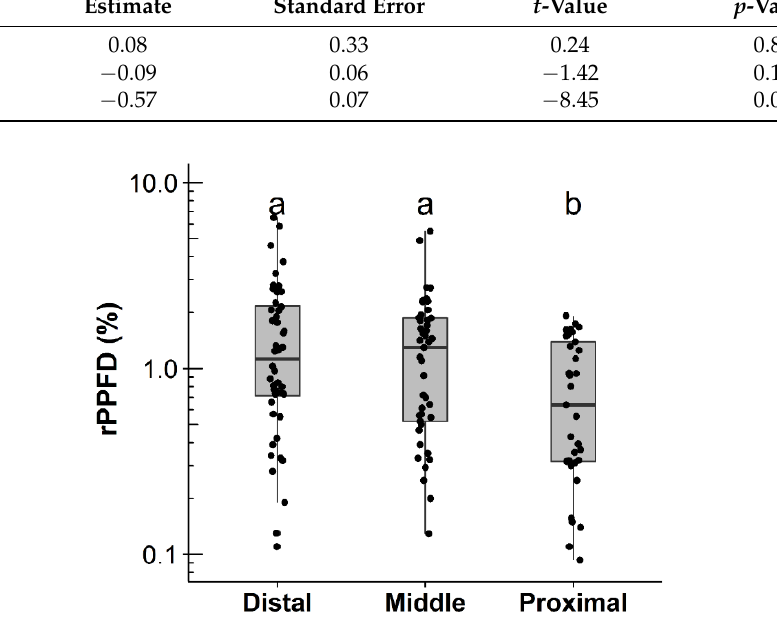
Figure 5. Comparisons between the secondary branch positions (distal, middle, and proximal parts of primary branches) of their relative photosynthetic photon flux density ln(rPPFD). Different letters indicate significant differences between groups ( p < 0.05, Tukey’s honest significant difference test). Length of a box indicates the interquartile range, where the horizontal lines inside each box represent the median, and the bottom and top of the box represent the first and third quartiles, respectively. The lower and upper whiskers show 95% confidence intervals. The closed circles outside the boxes represent outliers. The generalized linear mixed models coefficients are given in Table 4.